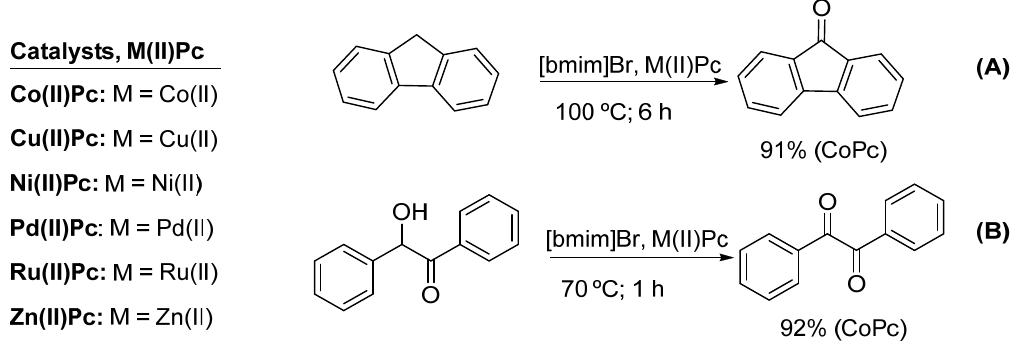
Figure 21. Metallophthalocyanine used for the aerobic oxidation of fluorene ( A ) and benzoin ( B ) in ionic liquids as solvent (adapted from [72]).